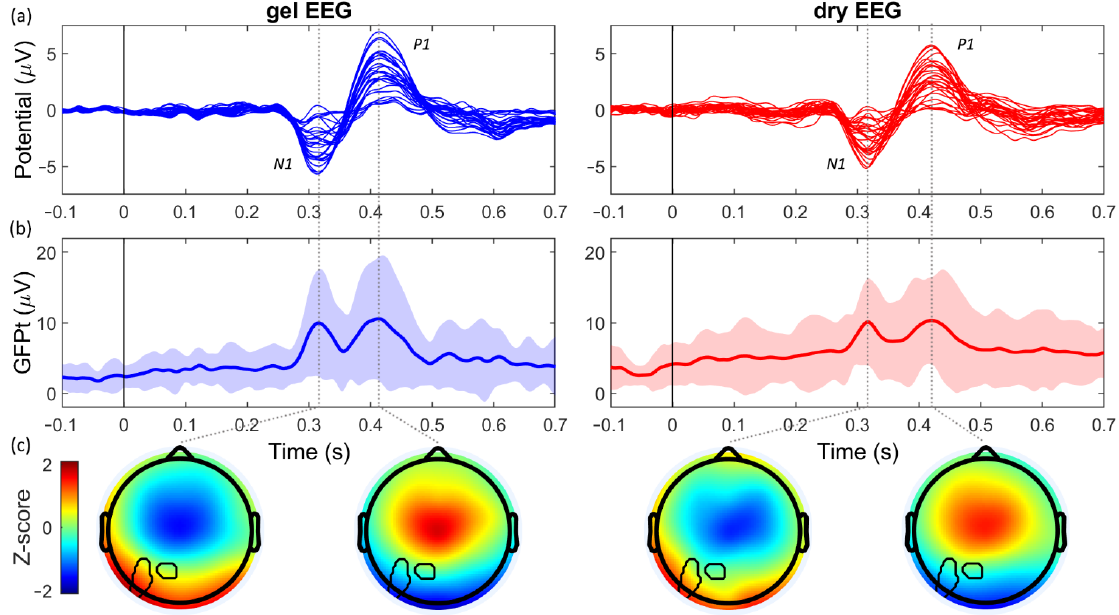
Figure 3. Auditory evoked potential (VEP) evoked by the auditory steady-state response task for the gel EEG system (blue; left) and dry EEG system (red; right). ( a ) The average AEP ( μ V) per channel over subjects. ( b ) The global field power over time (GFPt; μ V) averaged over subjects. Shaded areas indicate the confidence interval (mean ± 2x standard deviation). ( c ) The standardized topographic distribution (Z-score) of the two main components of the AEP. Black lines encircle the pixels that were significantly different between the two systems.